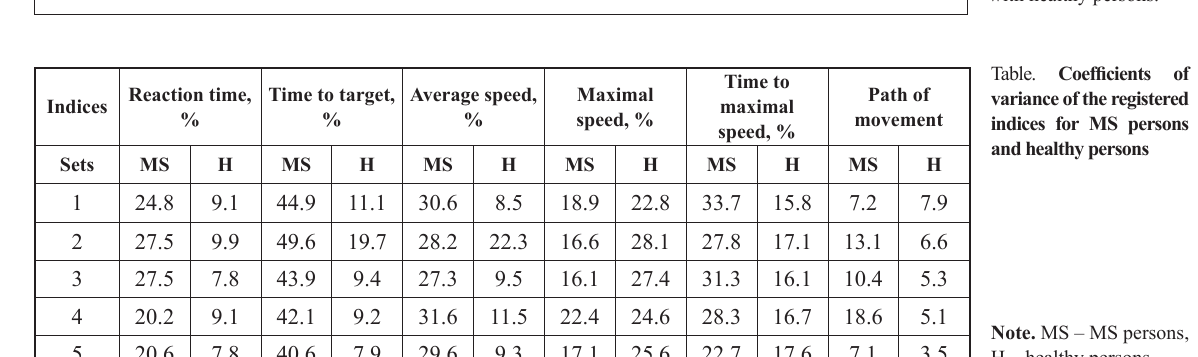
Table. Coefficients of variance of the